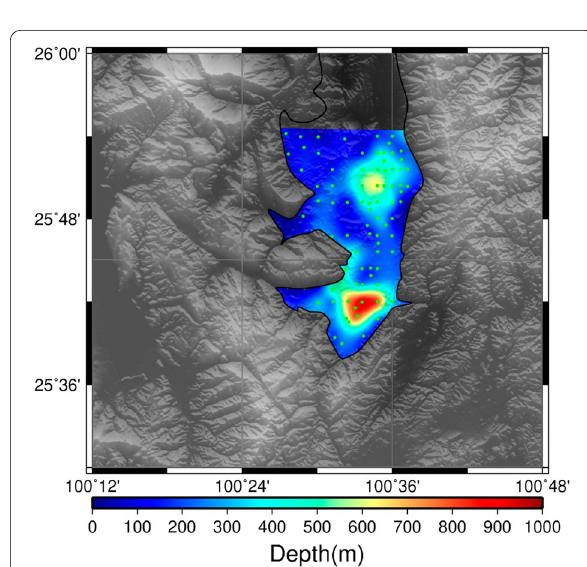
Fig. 15 Thickness of the sedimentary layer in the Binchuan Basin (Sun 2019). The green dots are the stations used in the